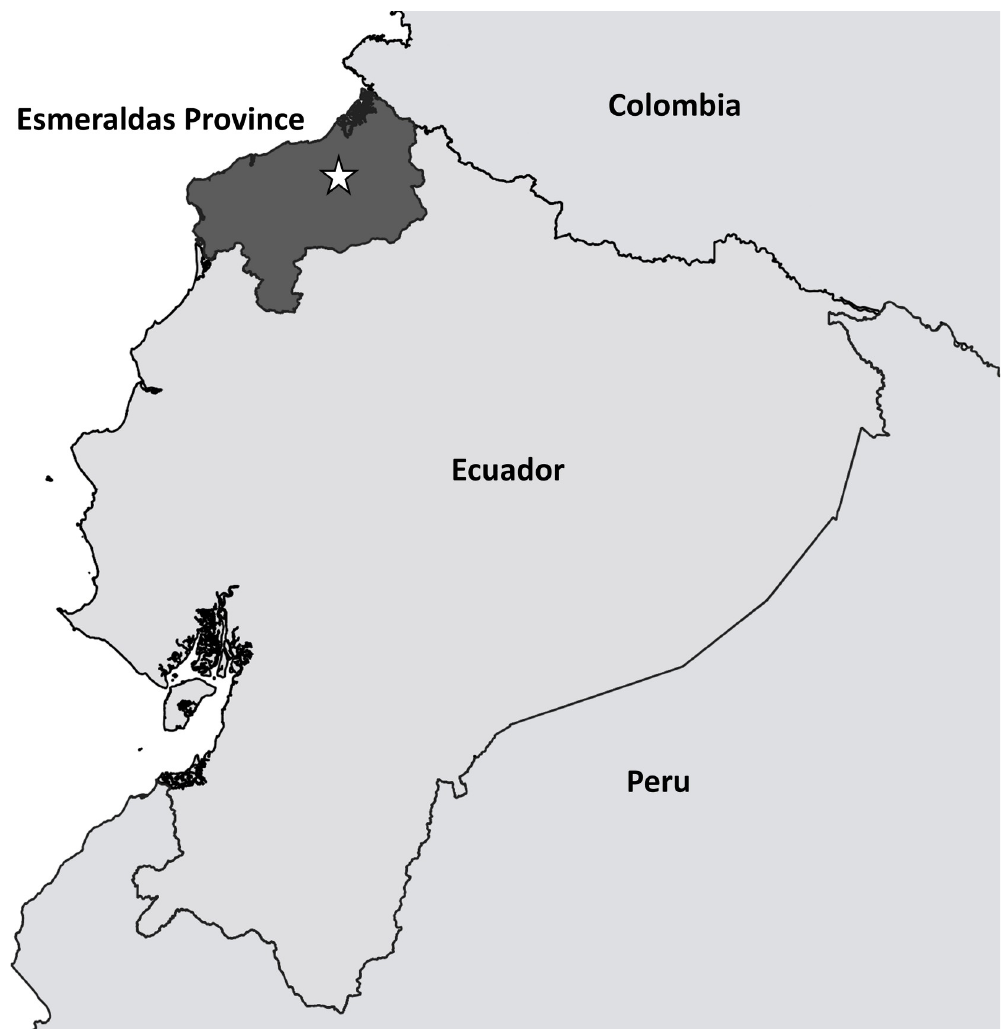
Fig 1. Map of Ecuador: The approximate location of the study community is indicated by the star. This map was constructed using shapefiles downloaded from https://data.humdata.org/, which is available under a CC BY-IGO license (https://data.humdata.org/dataset/ecuador-admin-level-2-boundaries).